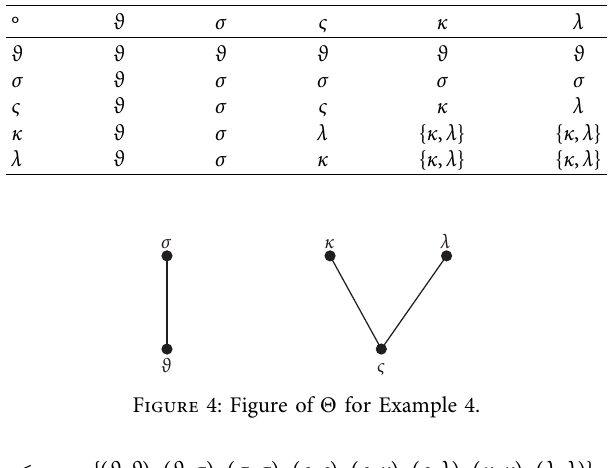
Table 4: LA-semihypergroup ( Θ � ϑ , σ , ς , κ , λ { } , ° ).